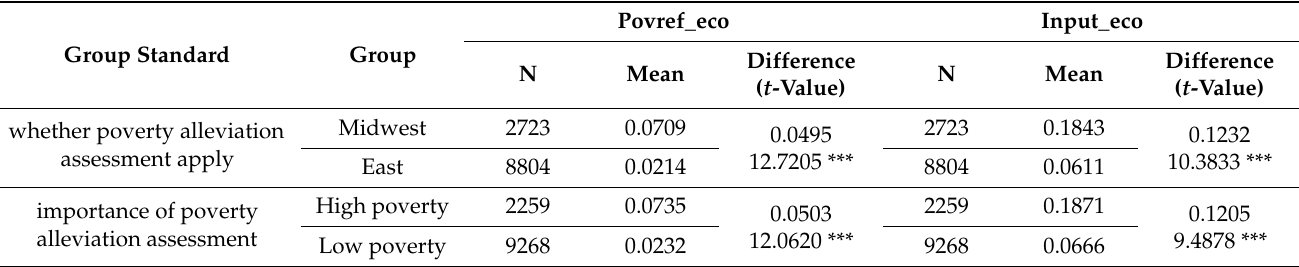
Table 3. Univariate